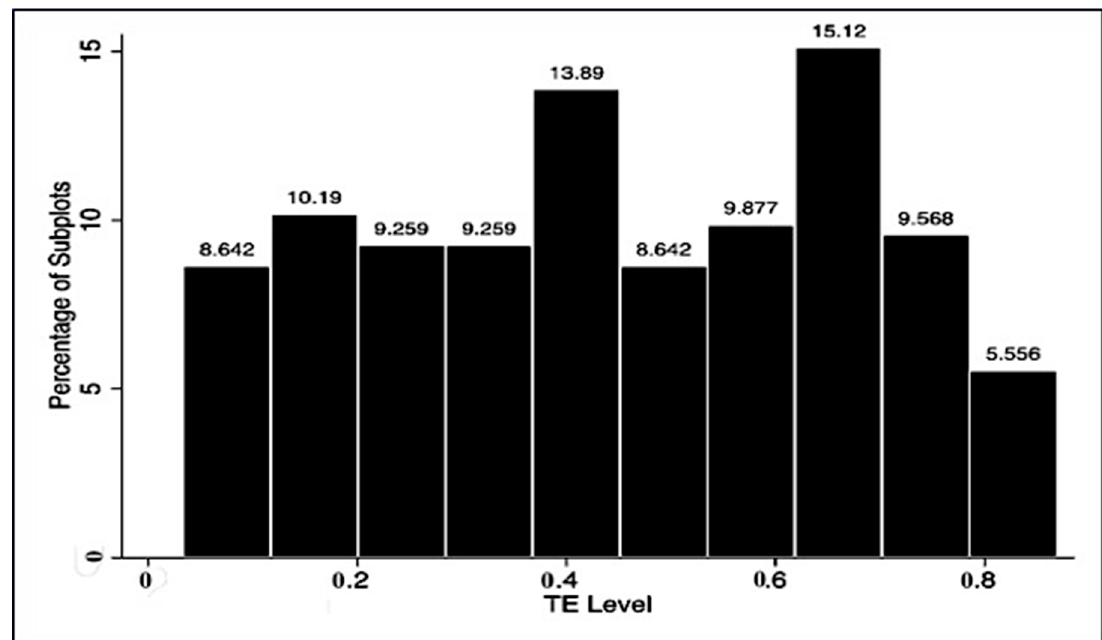
Figure 1. Percentage distribution of technical efficiency (TE) scores.